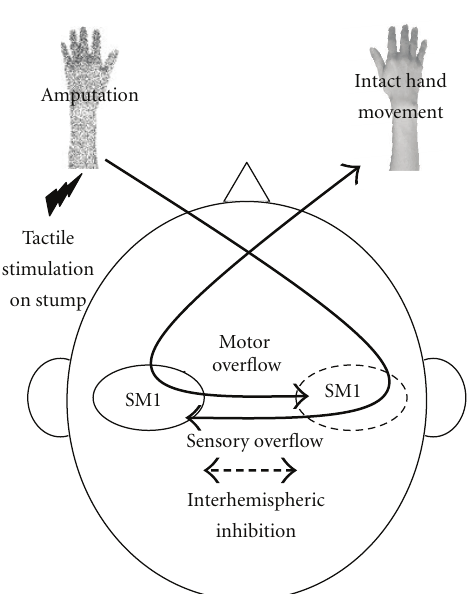
Figure 2: Amputation alters the interhemispheric interactions through the corpus callosum and induces bilateral neural activity. After amputation, reorganization of the dea ff erented sensorimotor cortex (SM1) occurs due to the absence of an a ff erent input from the missing hand. This change leads to an imbalance between the hemispheres in patients with amputations. Moreover, experience-dependent changes in representation by overuse of the intact hand increase this imbalance between the hemispheres. The imbalance between the hemispheres alters the interhemispheric interactions through the corpus callosum. In particular, the reduced interhemispheric inhibition observed in patients with amputations induces the neural activation of both hemispheres due to the failed inhibition of the opposite hemisphere. When tactile stimulation is delivered to the stump of the amputated limb, the overflow of the a ff erent information induces the activation of the nondea ff erented SM1. In addition to the sensory system, the motor overflow increases the activity of the dea ff erented SM1 during the movement of the intact